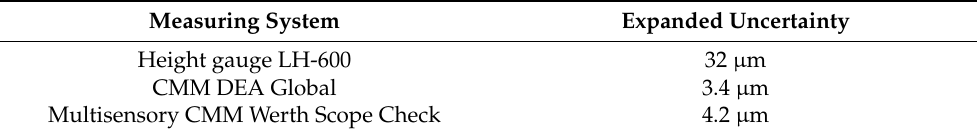
Table 1. Summary of uncertainties for the analyzed measurement systems (own study).